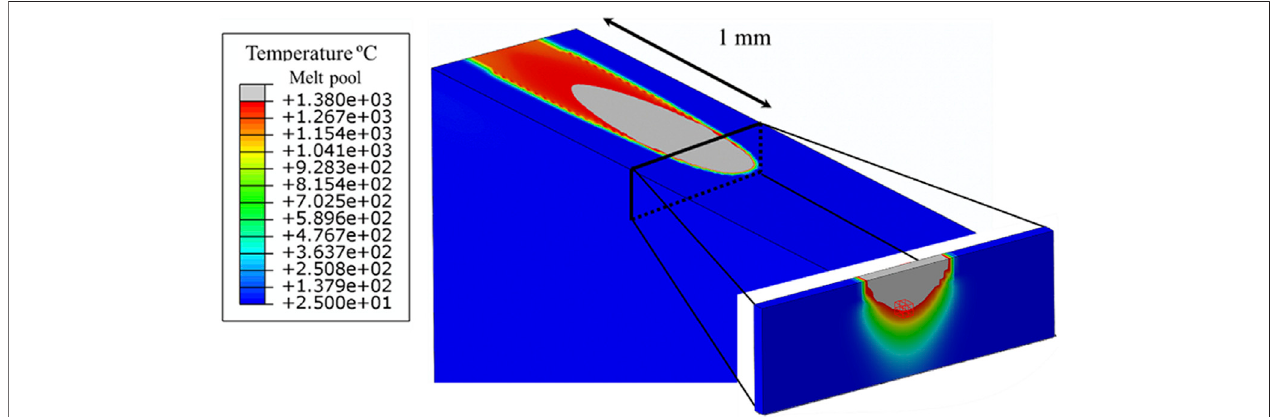
FIGURE 9 | Example of an ED laser track simulation used for HL model calibration. The melt pool is shown in grey color. The nodal temperatures of the elements surroundingthemeltpoolareusedforcalibrationoftheHLmodel.Thehighlightedregion(redcube)atthecenterofthecrosssectionatthemeltpoolboundaryisusedto study the cooling rate in Cooling rate